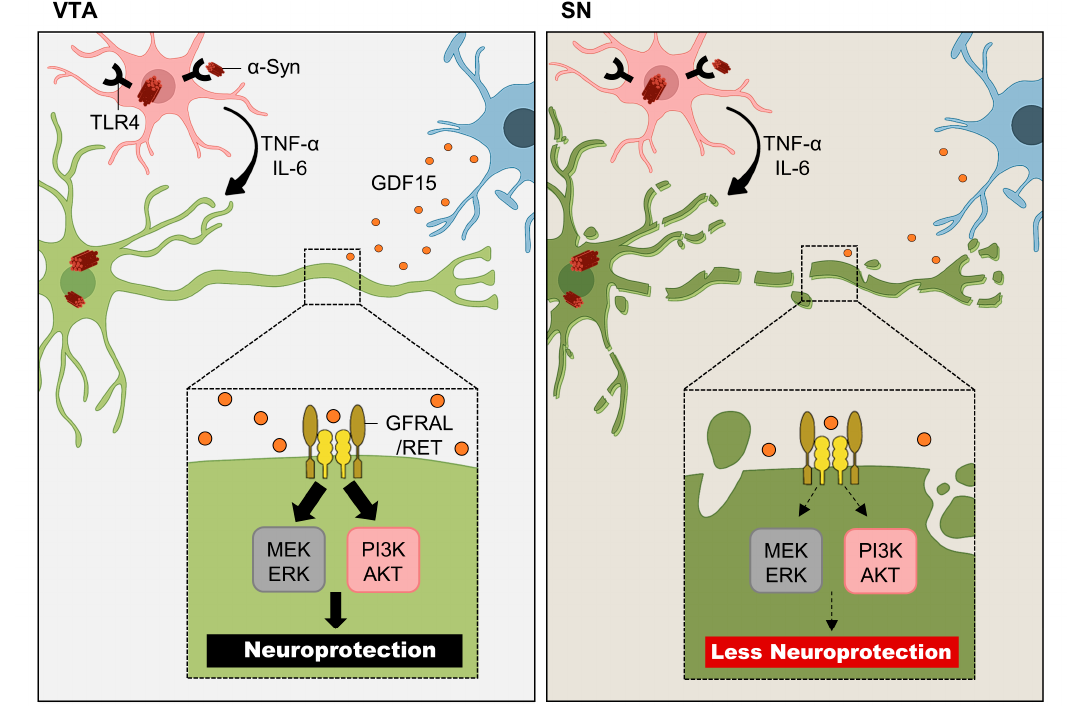
Figure 5. Implication of astrocytic and microglial regional heterogeneity in Parkinson’s disease. Substantia nigra (SN)-specific degeneration of dopaminergic neuron during Parkinson’s disease (PD) could be explained by the regional heterogeneity of astrocytes and microglia. The midbrain-specific microglia (pink) tend to show immune-alerted phenotype, highly expressing Toll-like receptor 4 (TLR4). Once the microglia uptakes α -synuclein through TLR4, it releases different pro-inflammatory cytokines, such as tumor necrosis factor- α (TNF- α ) and interleukin-6 (IL-6) that are toxic to neuron. In ventral tegmental area (VTA), astrocytes (blue, left panel) release significant amount of growth differentiation factor 15 (GDF15), which binds to GFRAL/RET complex (GDNF-family receptor α -like/rearranged during transfection) and causes its activation. The activated GFRAL/RET complex then further activates extracellular signal-regulated kinase (ERK) and protein kinase B (AKT) signaling pathways that mediate neuroprotection. On the other hand, astrocytes in SN (blue, right panel) release significantly less (230-fold) GDF15. This results in less activation of ERK and AKT signaling and, thus, less